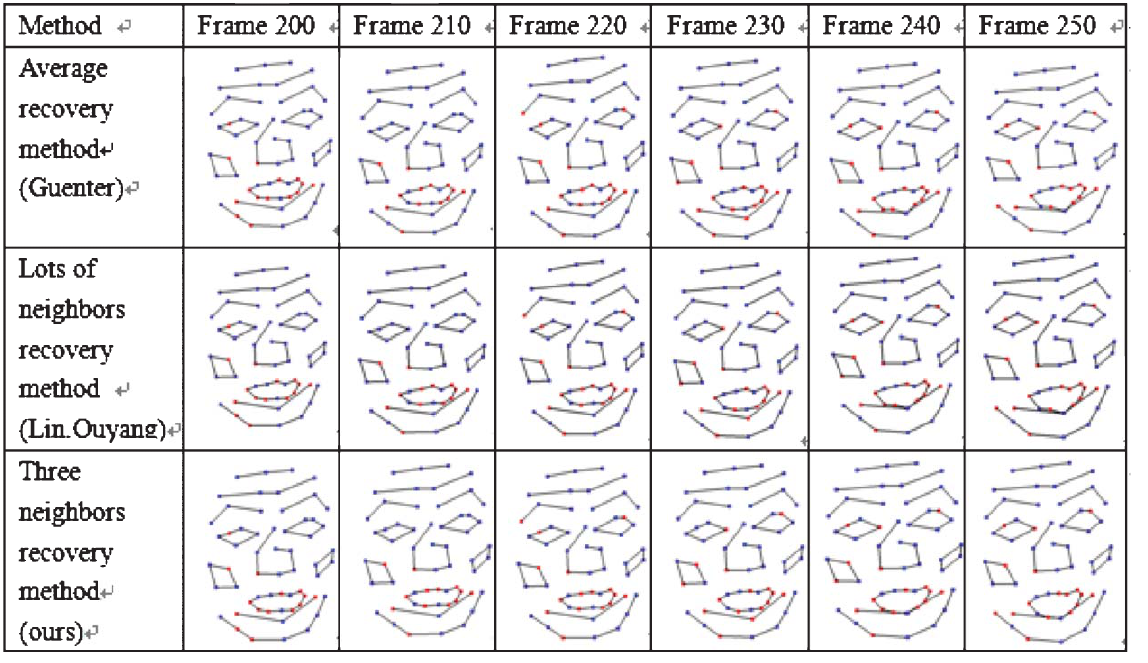
Fig. 6. Frames showing facial motion reconstruction with different recovery